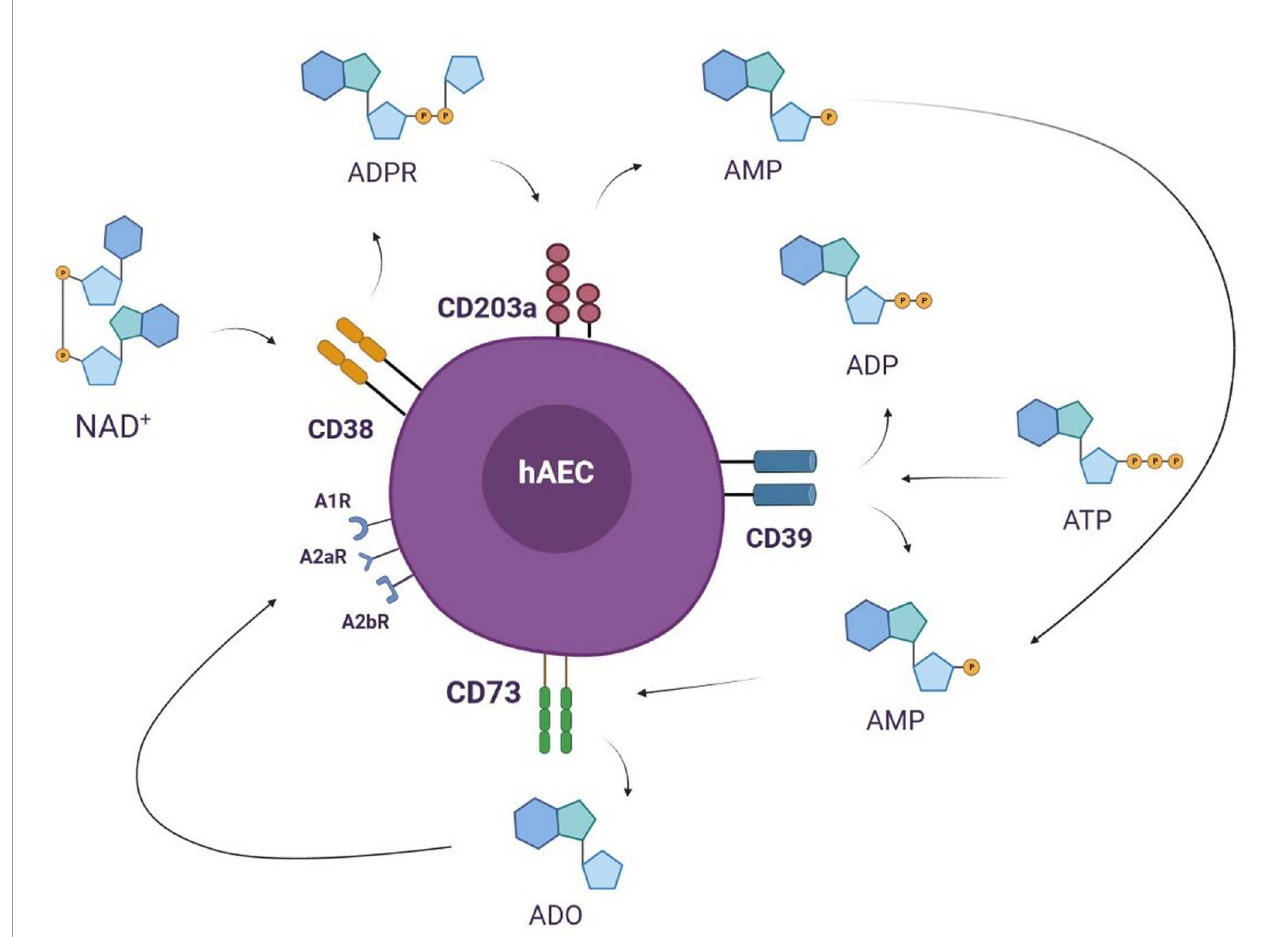
FIGURE 1 | The canonical pathway of ADO production initiates with CD39, an ecto- diphosphohydrolase responsible for hydrolyzation into mono- or di-phosphate nucleotide which are suddenly converted into soluble ADO by CD73. CD39 and CD73 can be present on the same cell or in close proximity when two cellular elements are adjacent. Interestingly, hAEC has been recently proved to constitutively expressed both canonical ecto-enzymes on membrane surface. However, such “ canonical ” way is not the sole molecular pathway responsible extracellular ADO production. Another “ alternative ” pathway has been described where nicotinamide adenine dinucleotide (NAD + ), rather than ATP, is the initiating factor for ADO production (and relative immune cell modulation). NAD can be actively secreted across cell membrane and trigger a cascade of extracellular signals, starting with CD38 resulting in soluble ADPR. CD38, another membrane ecto-nucleotidase, lends ADPR over to CD203a, a surface nucleotide pyrophosphatase/phosphodiesterase 1, that generate mono-phosphate adenosine (AMP). Similarly to “ classical ” pathway, AMP generated in the “ alternative ” cascade is converted into ADO by CD73, the point of contact for the two canonical and alternative